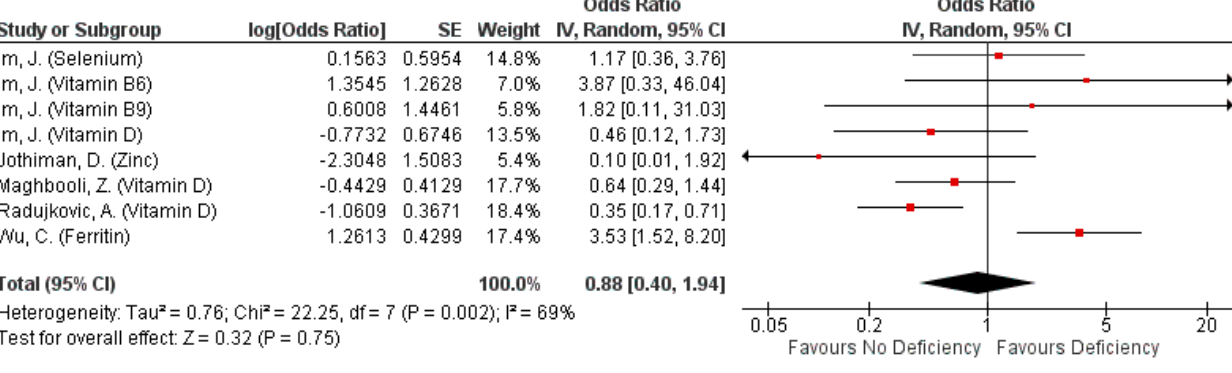
Figure 5. Pooled odds ratio on progression to respiratory-related complications due to COVID-19 episode when hospitalized subjects are not deficient, compared to those deficient in any micronutrient singly.